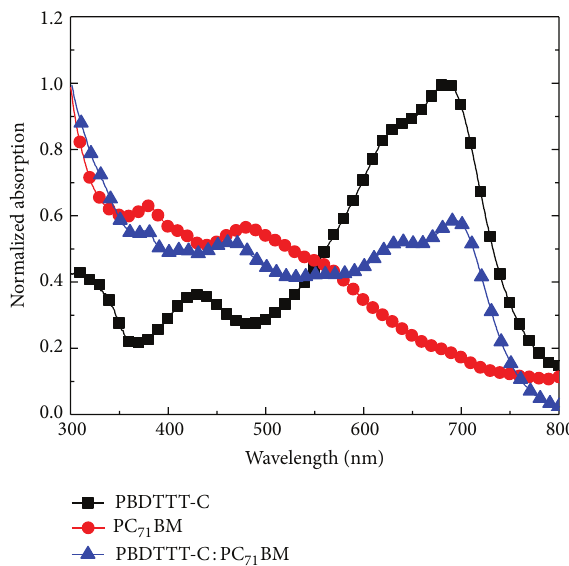
Figure 2: Normalized absorption spectra of PBDTTT-C, PC 71 BM, and their blend films with 1: 1.5 weight ratio.